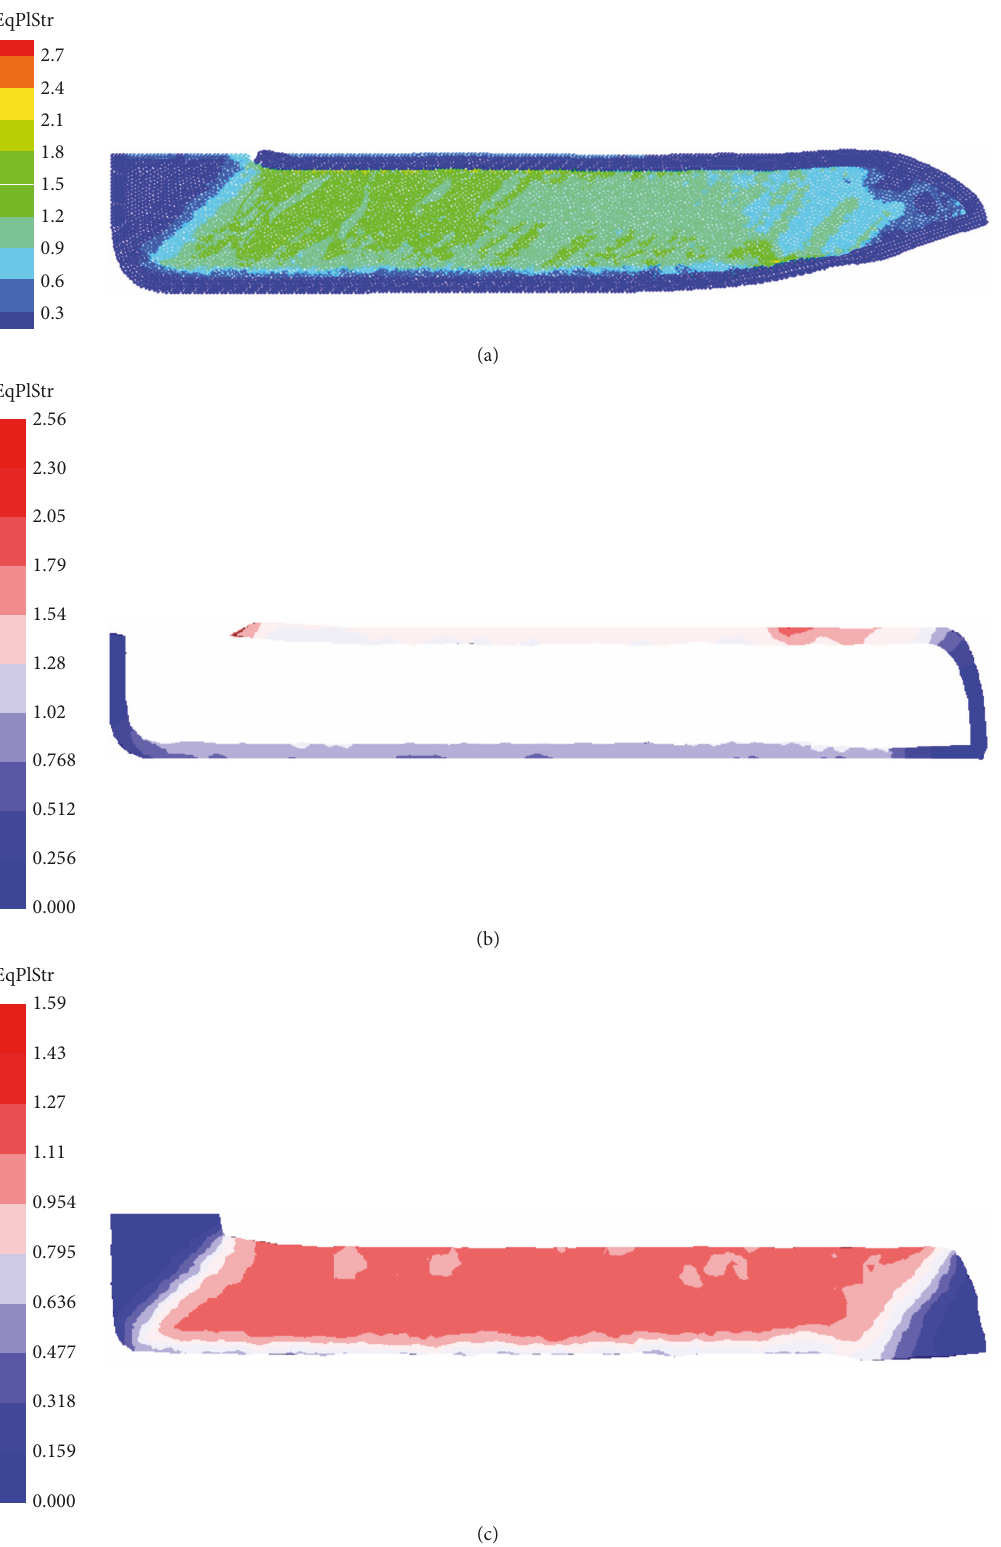
Figure 14: Computation results of equivalent strain distribution. (a) Computation results based on SPH. (b), (c) Computation results based on finite element